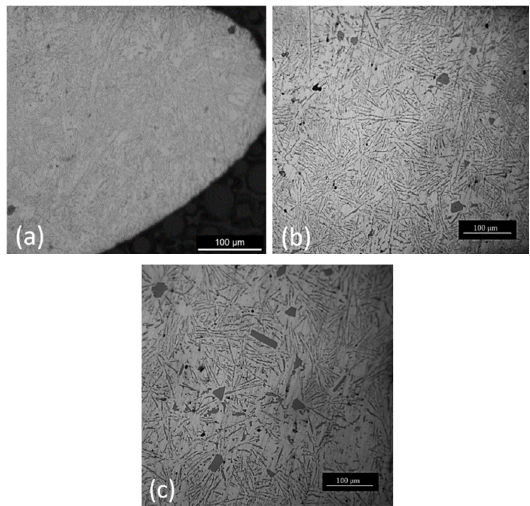
Figure 13. Eutectic silicon numeric fraction variation of samples poured at 635 °C in a mold at 350 °C for different sample wall